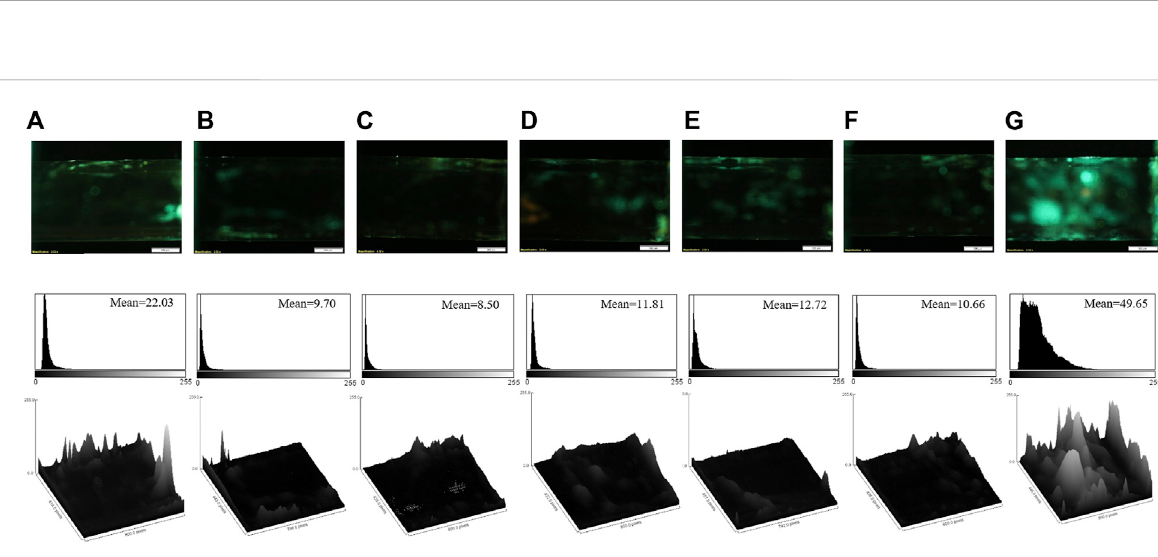
corresponding mean brightness values, and surface plots in the presence of the various drugs are gathered in Figure 4. Figure 4 clari fi es that the other drugs could not enhance the fl uorescence